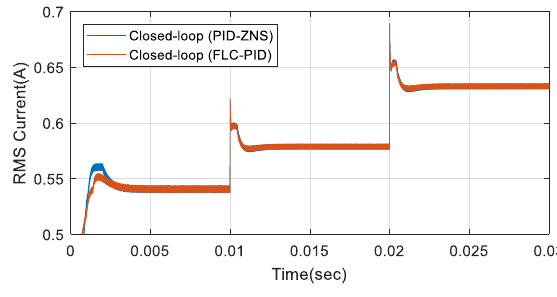
Fig.11: ESU output RMS current for the original controller.